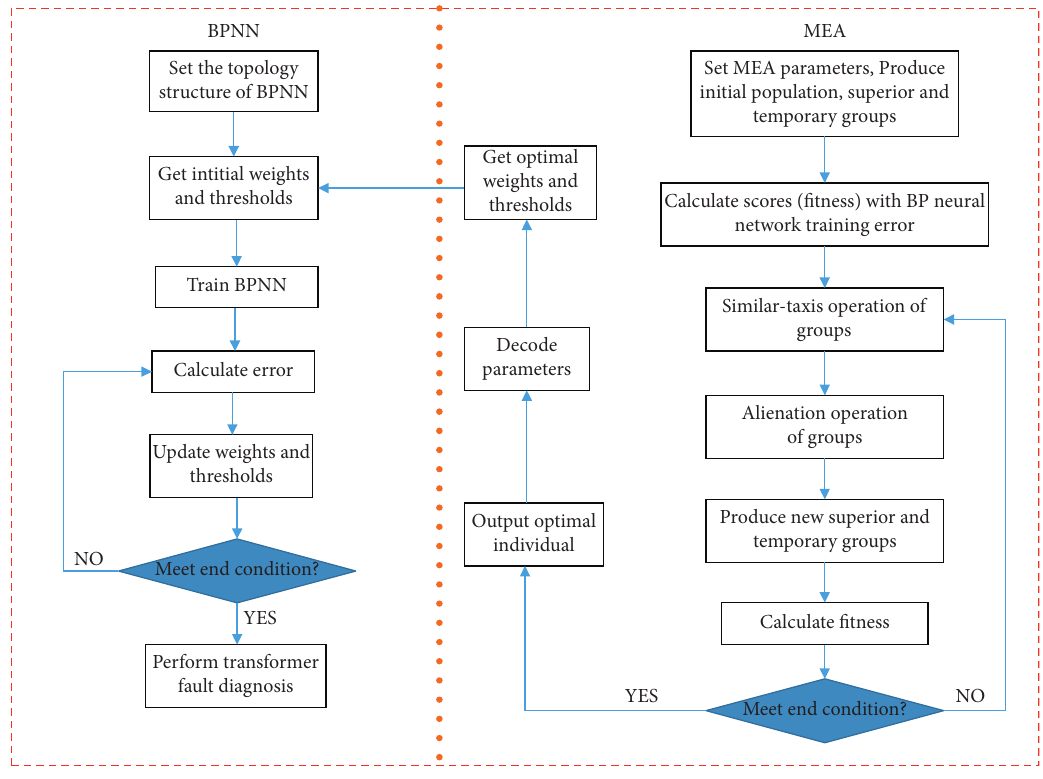
Figure 12: Global flowchart of MEA-BPNN method.